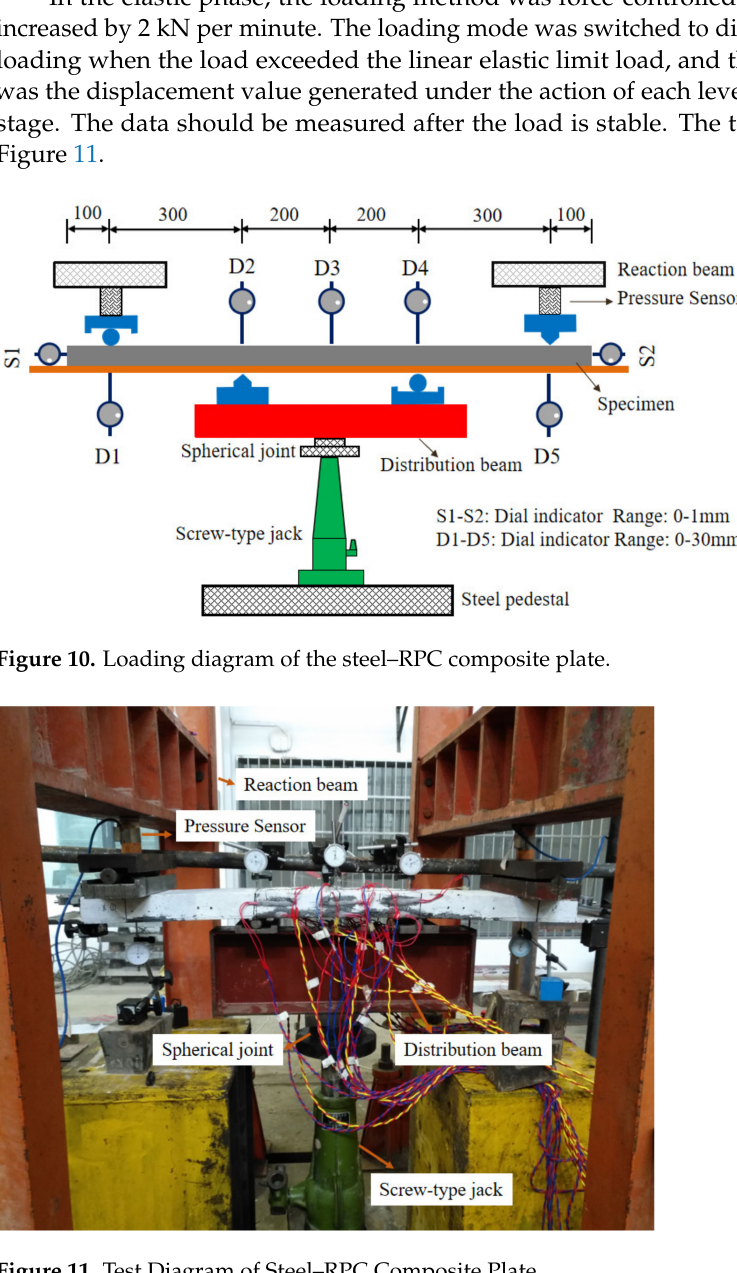
Figure 11. Test Diagram of Steel–RPC Composite